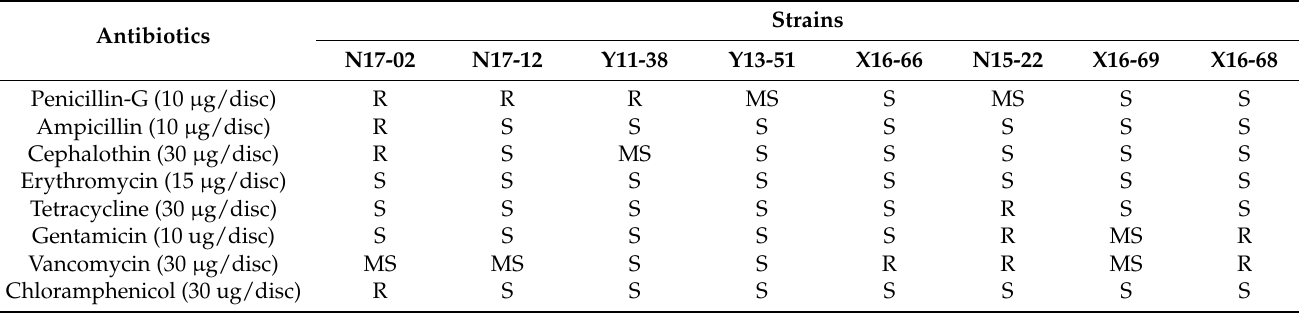
Table 6. Antibiotic susceptibility of probiotic